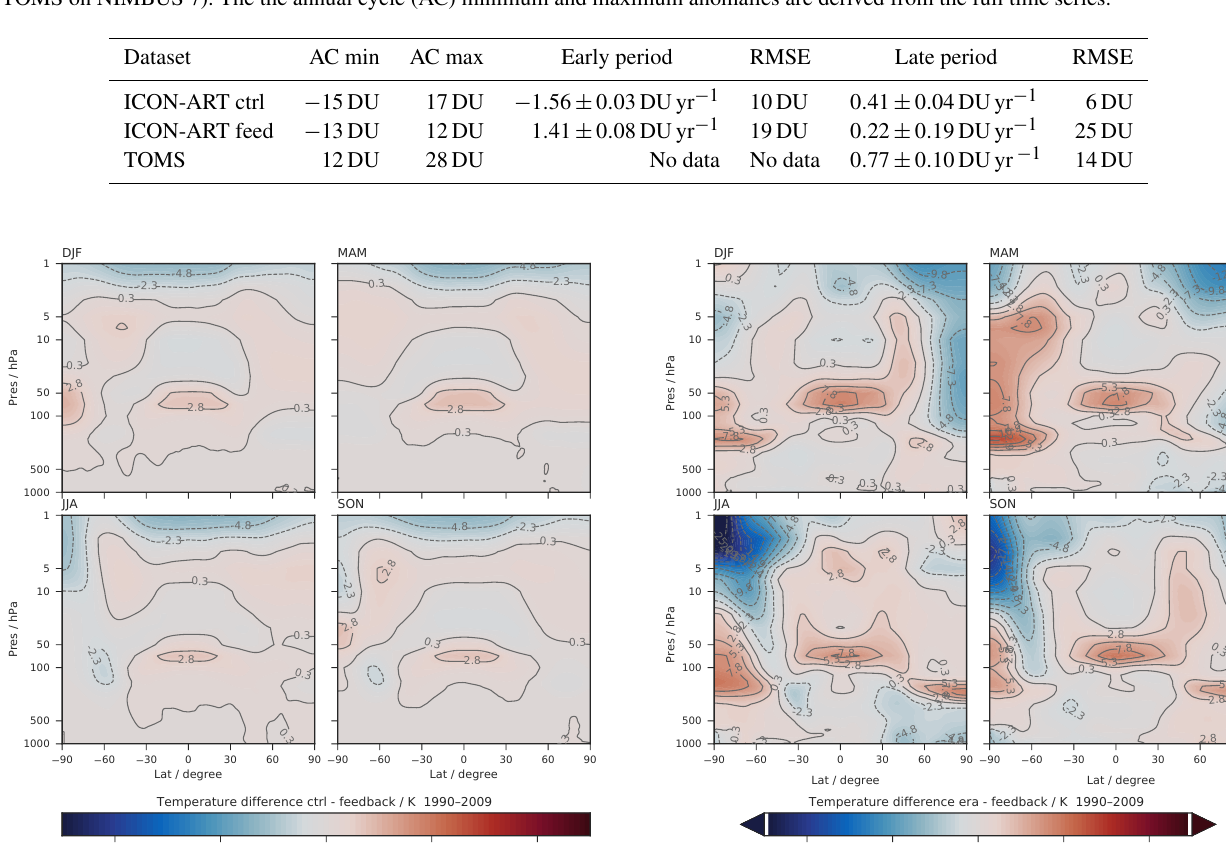
Table 3. Results of the time series analysis for different time domains at 60 ◦ S for the ozone total column. Results for both ICON-ART simulations and TOMS observation are shown. The early period is from 1980 to 1997 and the late period is from 1997 to 2009 (to 2005 for TOMS on NIMBUS 7). The the annual cycle (AC) minimum and maximum anomalies are derived from the full time series.